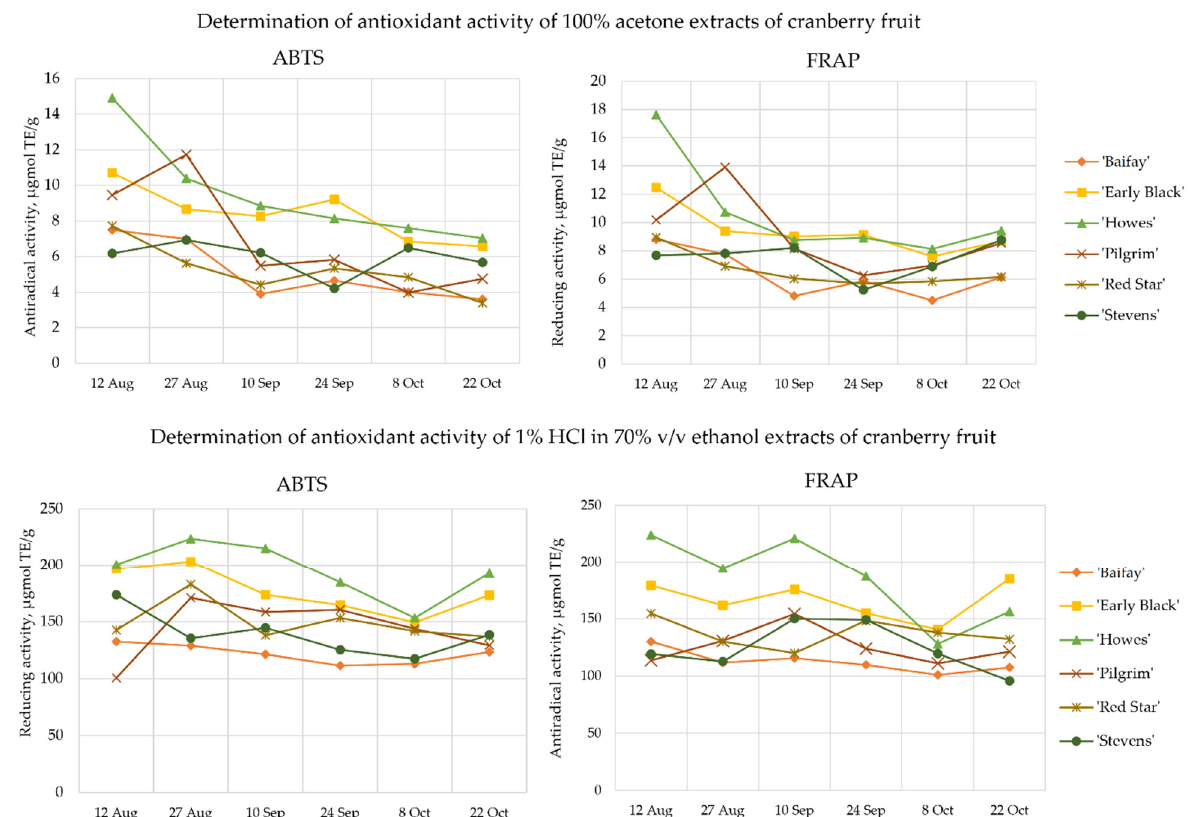
Figure 6. Variability of antioxidant activity in fruit samples of large cranberry cultivars during rip-